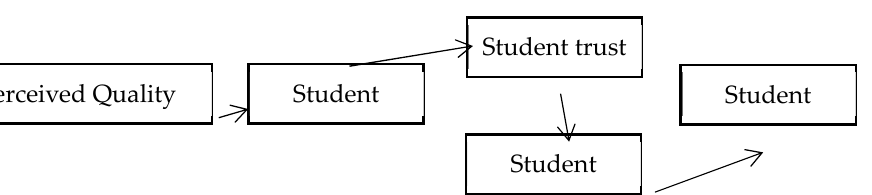
Figure 1. Model processed after Rojas-M é ndez et al. [29]. “Reprinted/adapted with permission from Ref. [29].